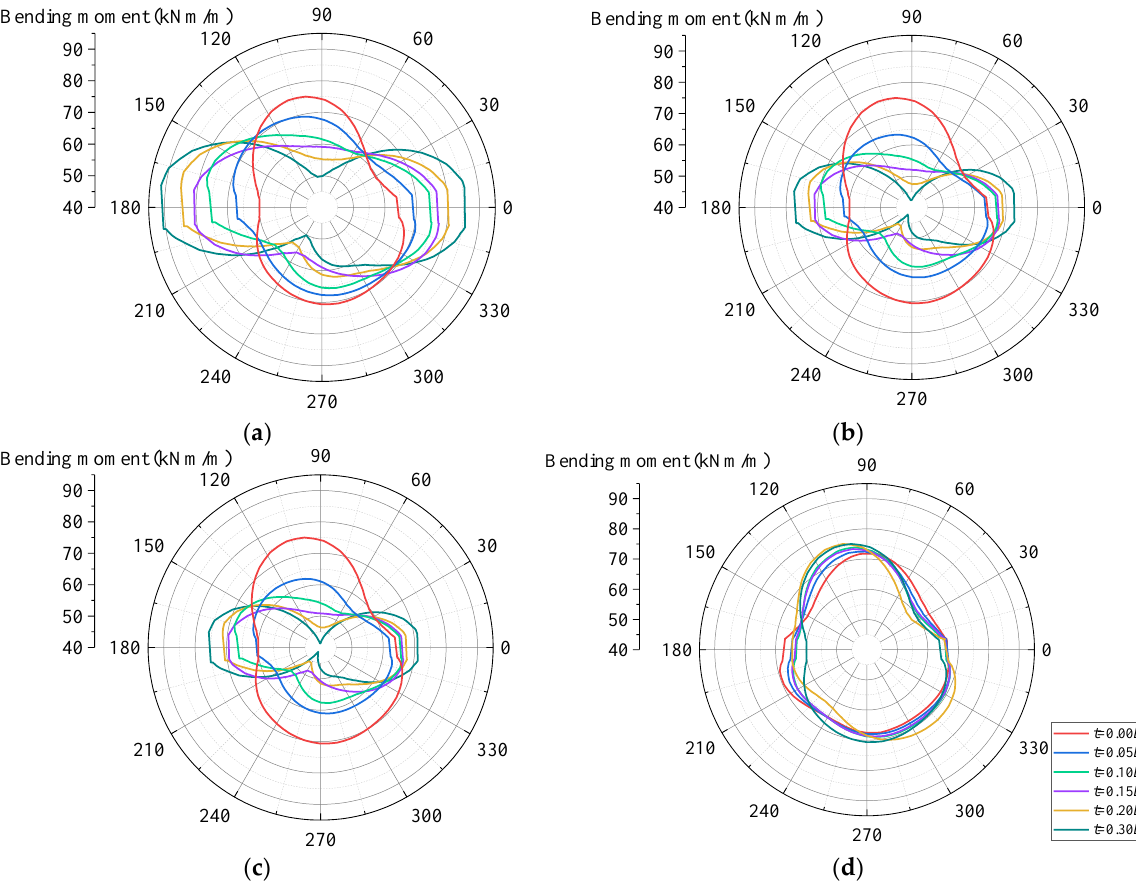
Figure 11. Bending moment of the lining of preceding tunnel: ( a ) RR; ( b ) LR; ( c ) TR; ( d ) CR.